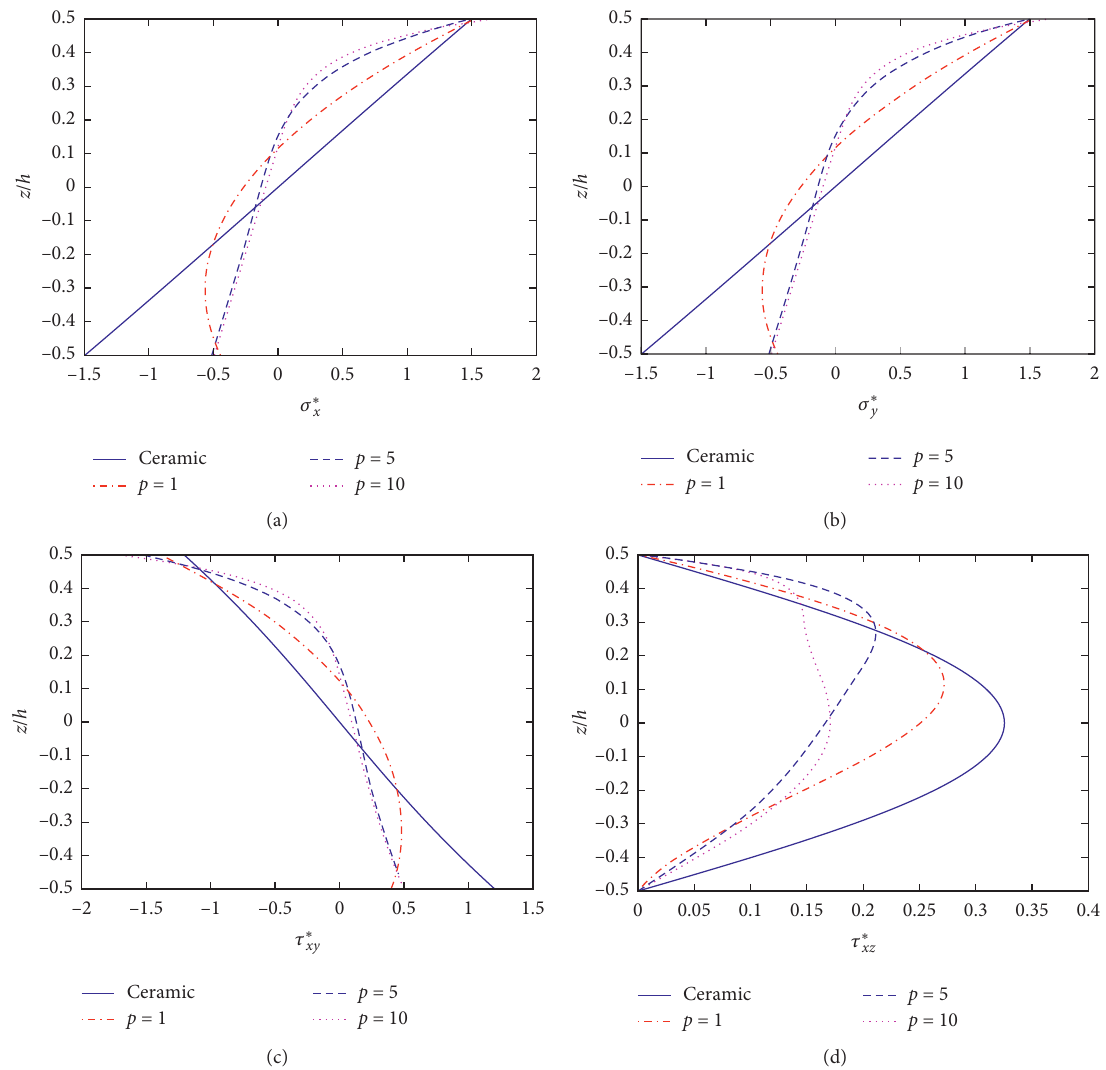
Figure 3: The distribution of the stresses through the thickness of the FGM